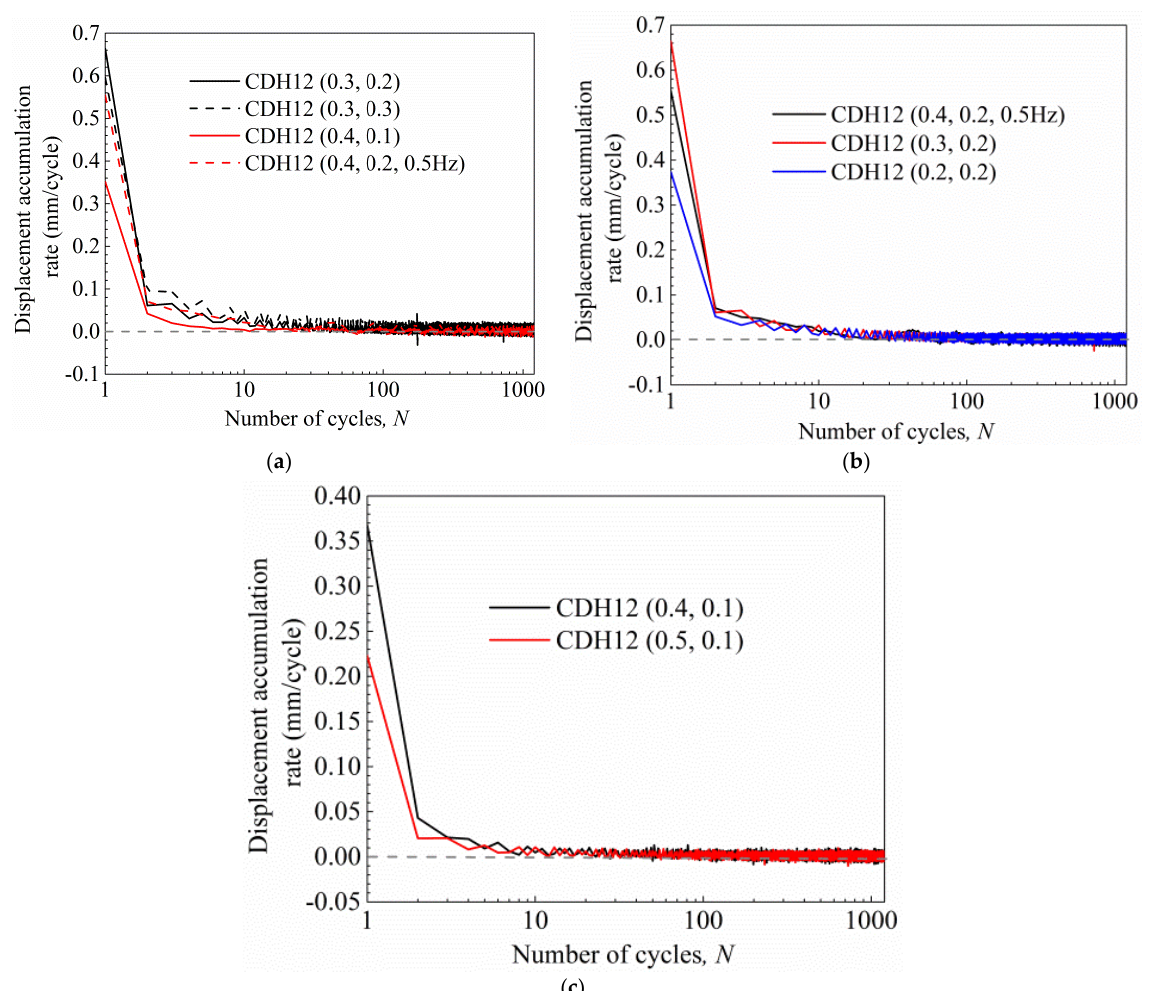
Figure 12. Developments of displacement accumulation rate under different amplitudes and mean loads: ( a ) the influence of amplitude; ( b ) the influence of mean cyclic load Q cyc / Q t = 0.2; ( c ) the influence of mean cyclic load Q cyc / Q t = 0.1.